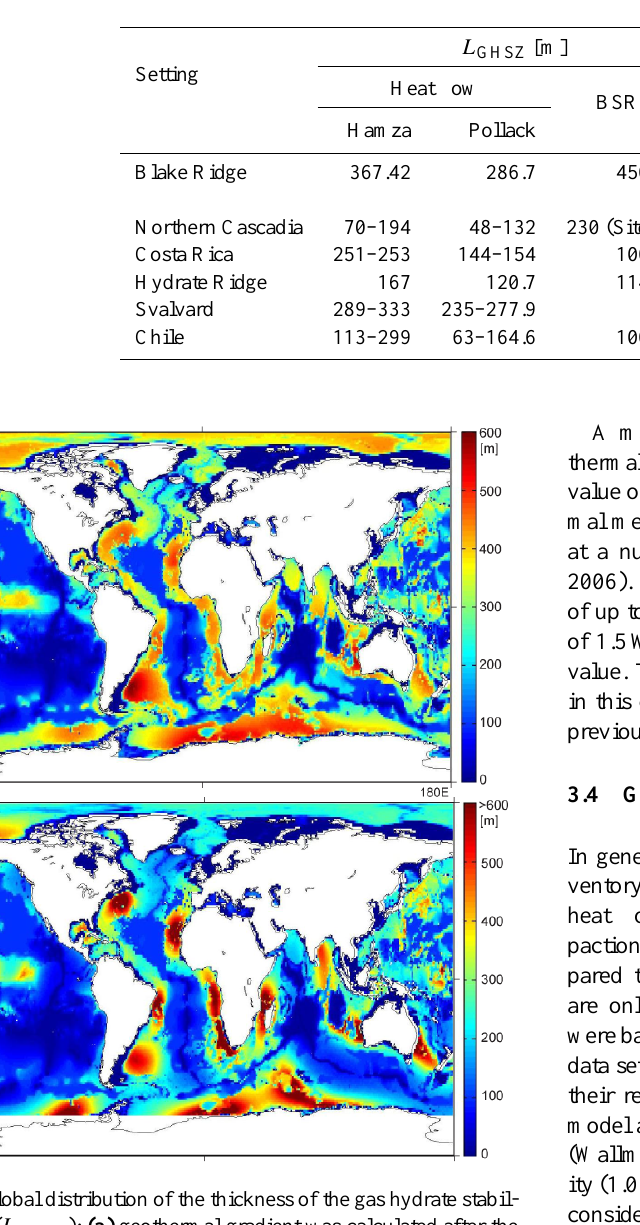
Table 2. Comparison of the thickness of the GHSZ calculated with the global grids and heat flow values of Hamza and Pollack, to other published results obtained after the calculation of the BSR depths, obtained through geophysical methods.